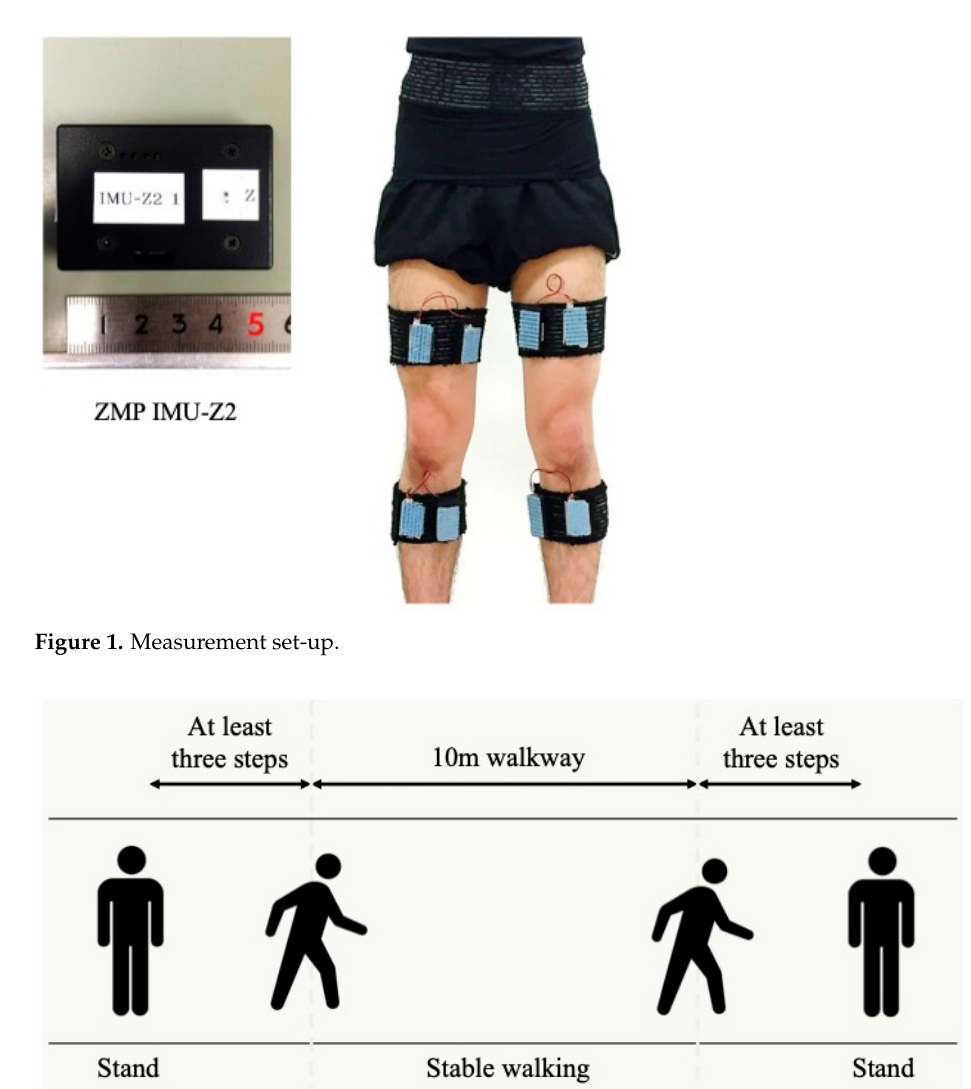
Figure 2. Gait analysis overview.